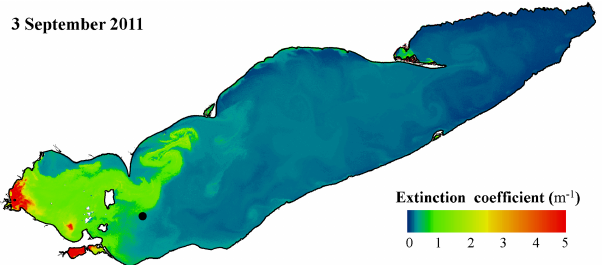
Figure 9. Spatial variation of satellite-derived K d in Lake Erie, on 3 September 2011. Location of NDBC station is shown on the map as a solid